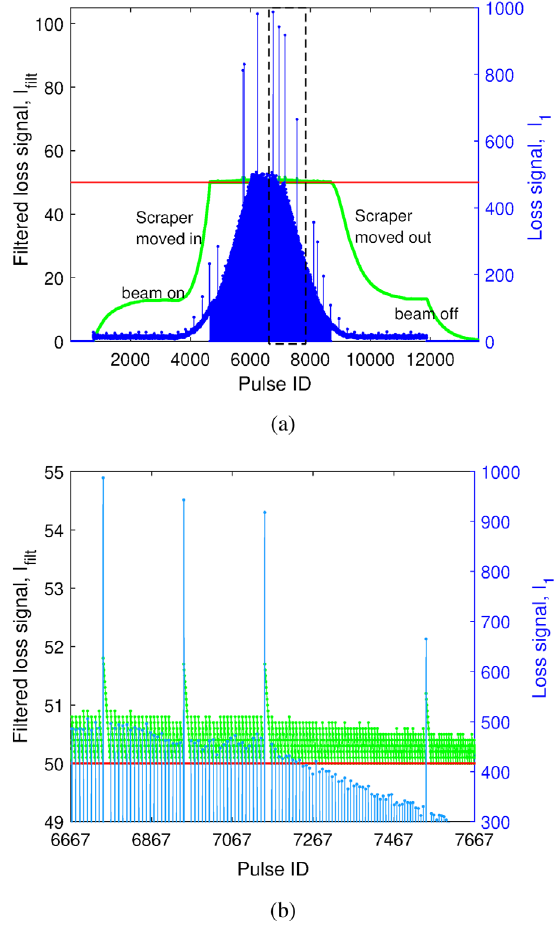
FIG. 6. Beam losses observed by an LLM due to collimator moved into beam path. (a) Plot shows the loss signal (blue) and the filtered loss signal (green). The black dashed box is enlarged in (b) where the behavior of the MPS can be clearly seen. When the filtered loss signal reaches the MPS Level 1 alarm threshold, the beam is stopped. The larger the loss signal, the longer it takes for the MPS to allow the beam.